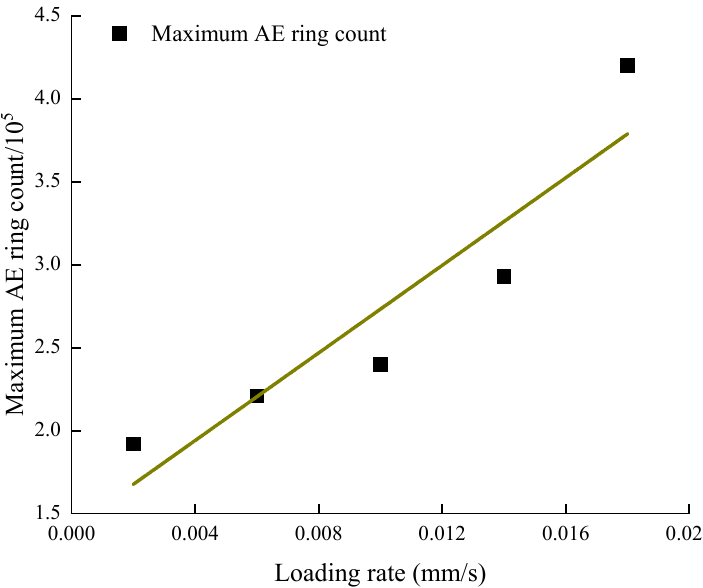
Figure 7. Variation of maximum AE ring counts with increasing loading rate.